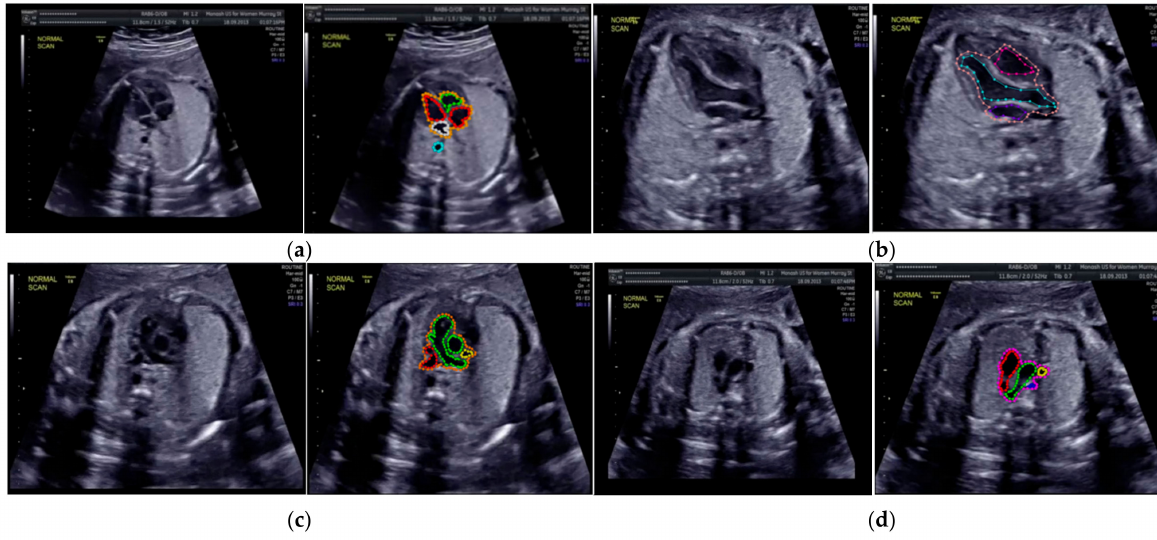
Figure 4. The sample of annotated images by maternal–fetal clinician for standard fetal heart view segmentation in ( a ) 4CH (orange: view, cyan: AoA, red: LA, grey: RA, green: LV, and red: RV); ( b ) LVOT (orange: view, cyan: LA, purple: RV, and blue: LV); ( c ) RVOT (orange: view, green: MPA, red: DUCT, and yellow: SVC); and ( d ) 3VT (purple: view, yellow: AoA, green: SVC, and red: DUCT); based on normal